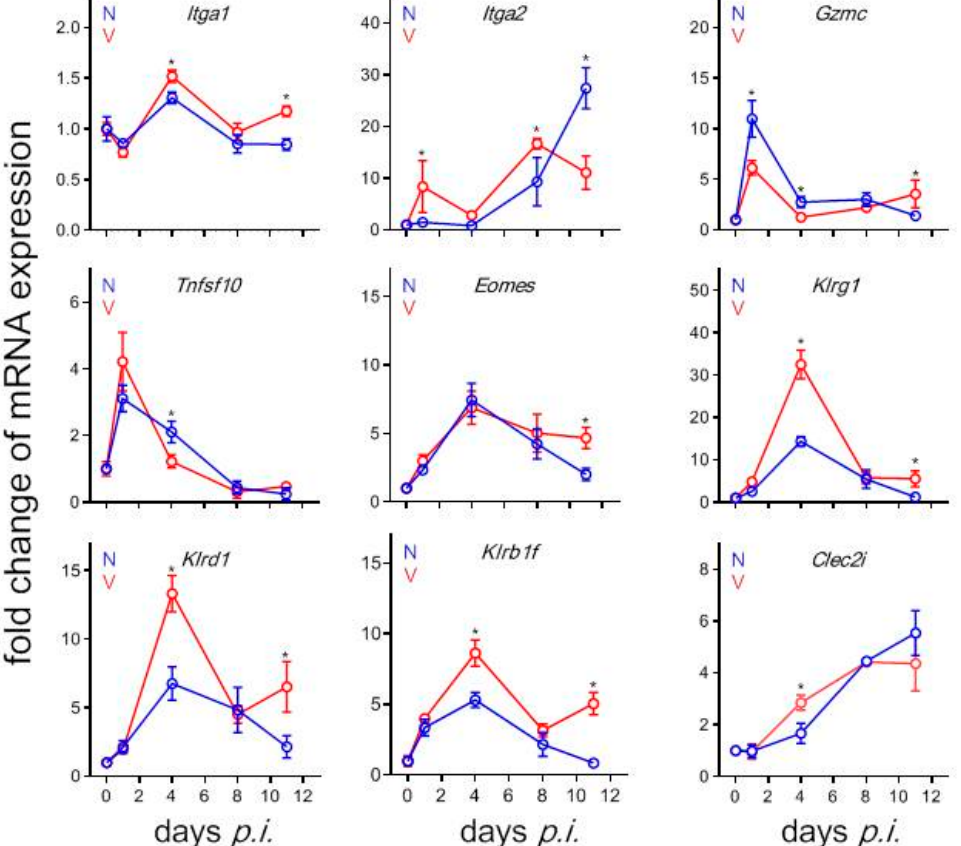
Figure 8. qRT-PCR of mRNAs in the liver of vaccinated (V, red) and non-vaccinated (N, blue) Balb/c mice. RNA was isolated from individual livers prepared from mice infected with P. chabaudi on different days p.i. Means ± SD of duplicate determinations performed with liver aliquots from three different mice. “*” indicate significant differences between vaccinated and non-vaccinated mice ( p < 0.05).